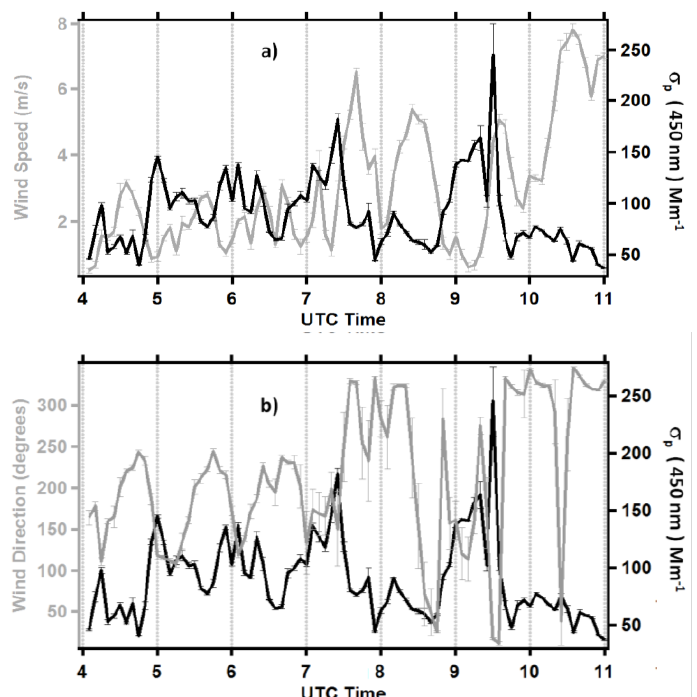
Figure 7. Time evolution of the two-hour averaged values of ( a ) wind speed (grey line) and σ p (black line), and ( b ) wind direction (grey line) and σ p (black line). The error bars represent the corresponding SEMs.